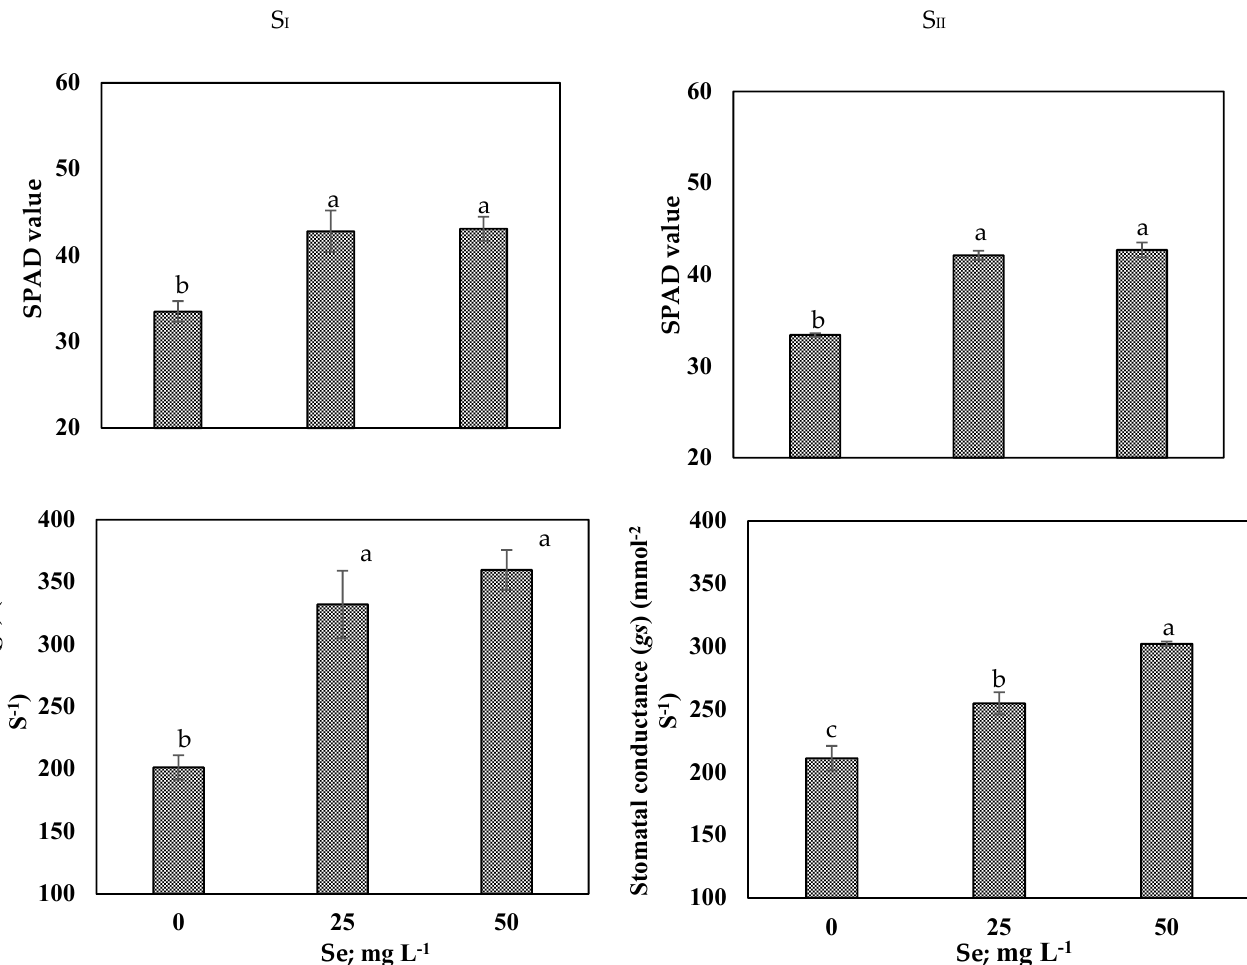
Figure 2. Effects of selenium (Se; mg L − 1 ) foliar applications on SPAD value and stomatal conductance ( g s ) of onion under saline soil (EC = 5.2 dS m − 1 ) conditions in S I and S II seasons. Vertical bars represent means ± S.E ( p ≤ 0.05). Columns marked by different letters are significantly